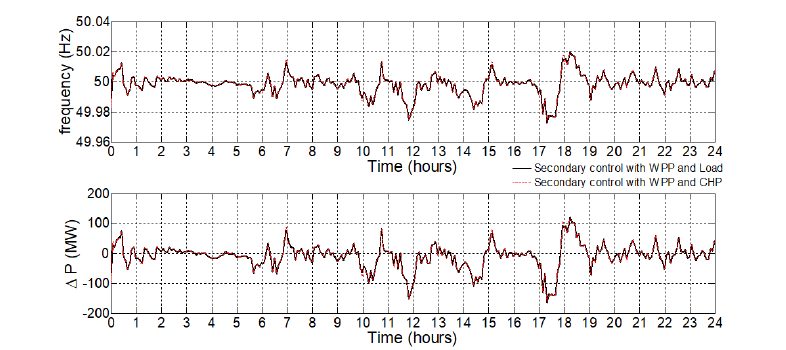
Figure 13. Power system frequency and deviation in power exchange with